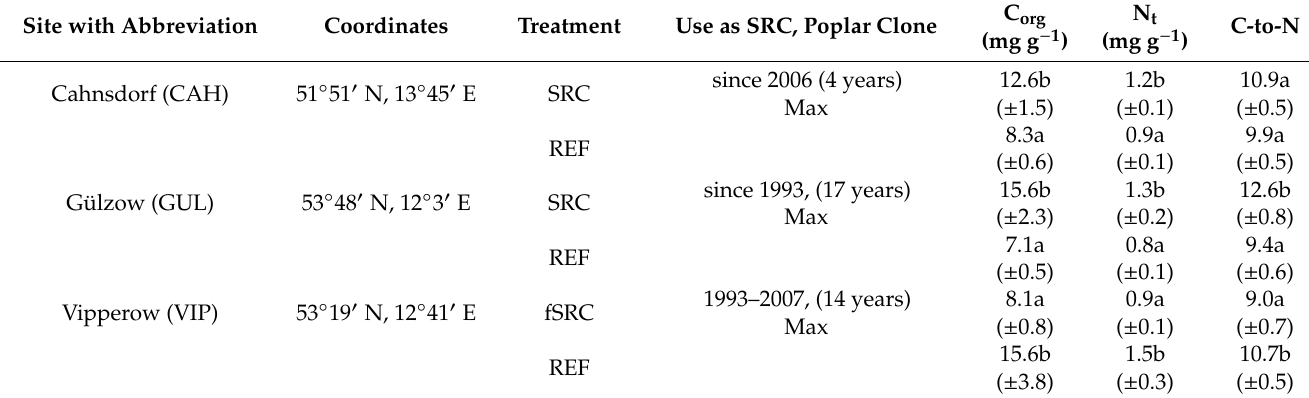
Table 1. Site coordinates, treatment, period of use as SRC, C org -, N t - content and C-to-N ratio in the soil depth of 0–5 cm at the test sites Cahnsdorf (CAH), Gülzow (GUL) and Vipperow (VIP) in